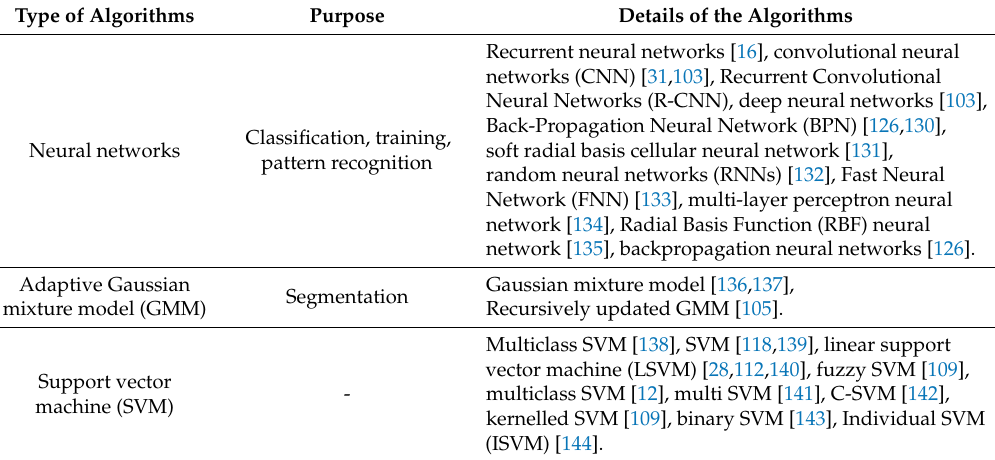
Table 4. Some of the most common soft-computing methods used for pattern recognition, classification, training or prediction in GPS, video image, aerial images, radar, magnetic sensor-based vehicle